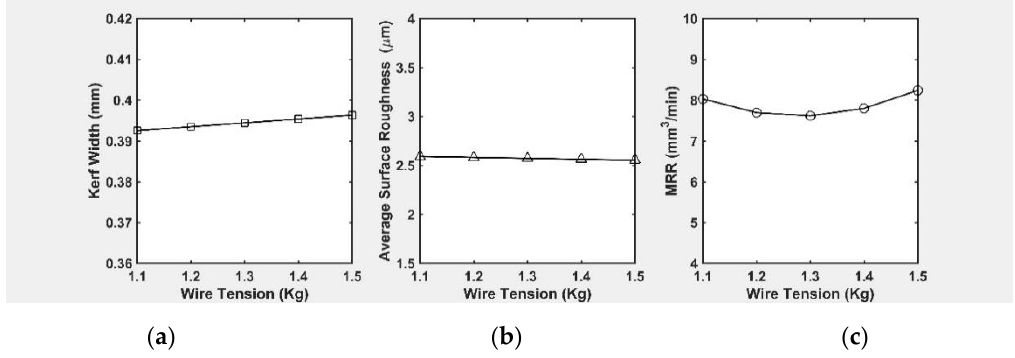
Figure 8. Effects of wire tension (WT) on ( a ) kerf width, ( b ) surface roughness, and ( c ) MRR.